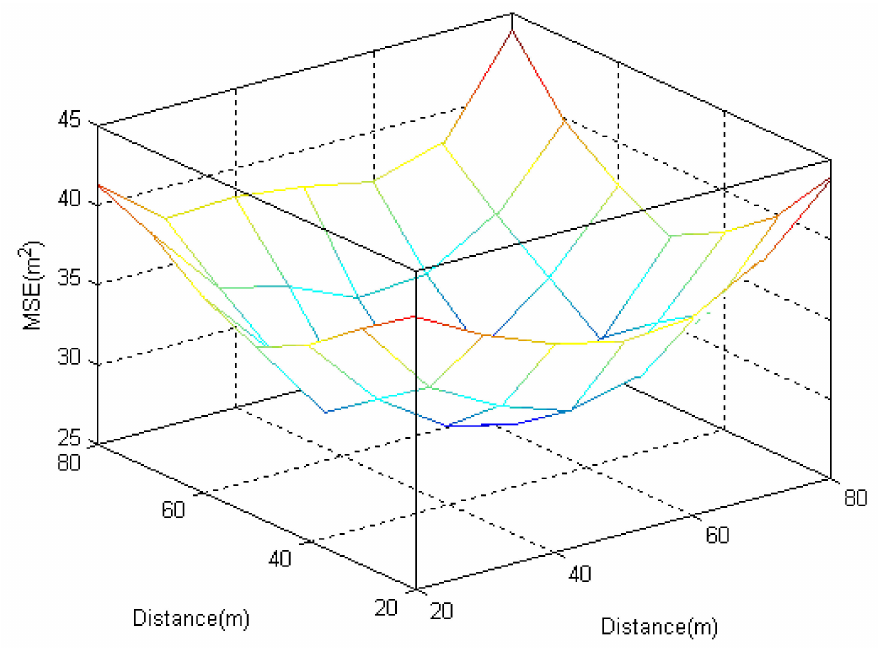
Figure 16. Three reference nodes to estimate the small